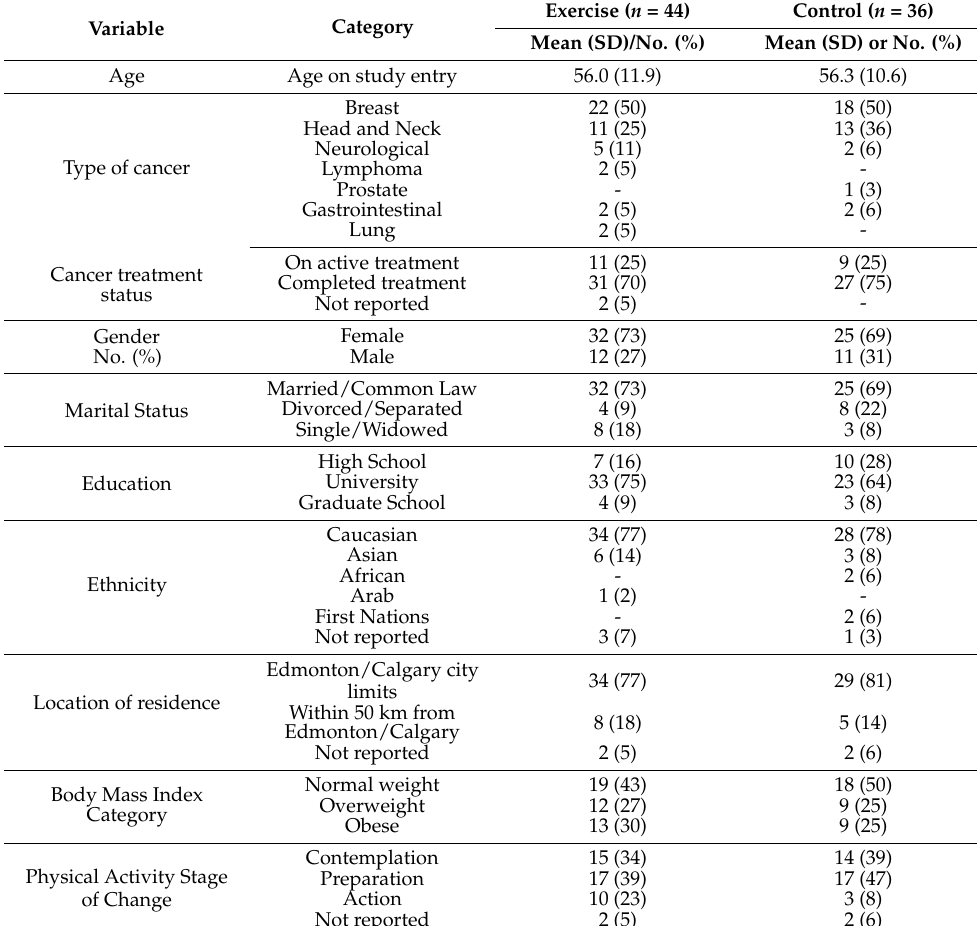
Table 1. Baseline Demographics.